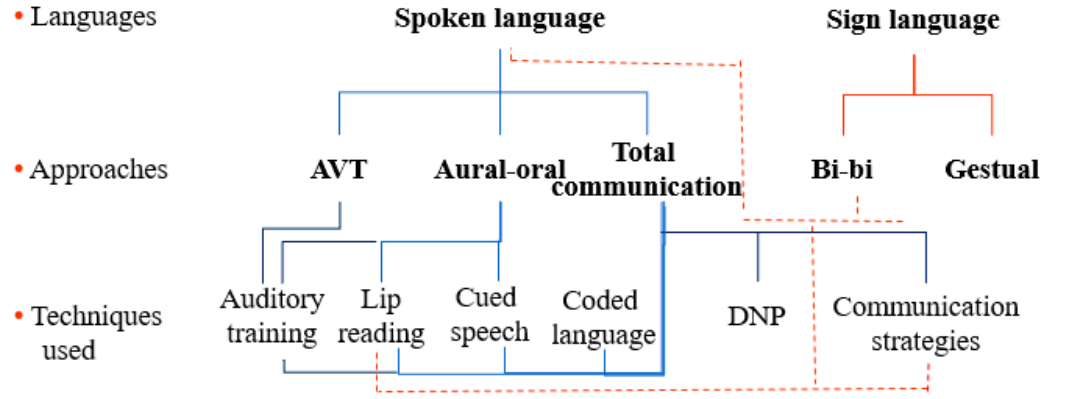
Figure 2. Relations between languages, approaches and techniques.